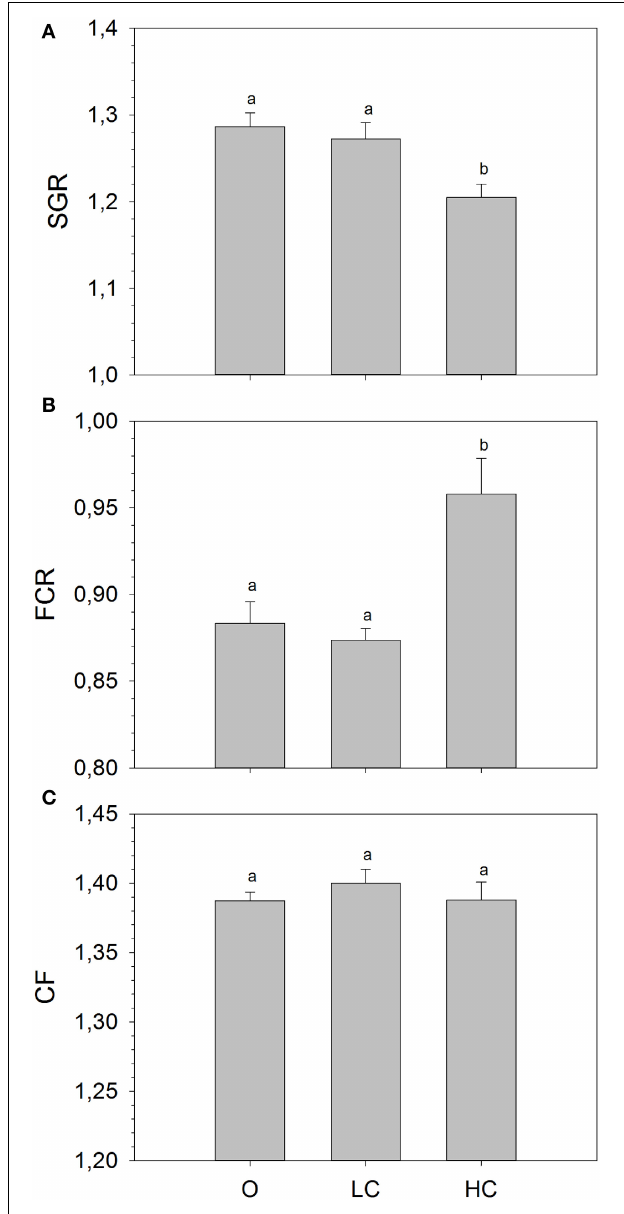
FIGURE 1 | (A) Specific growth rate (SGR), (B) Feed conversion ratio (FCR), and (C) Condition factor (CF) calculated for the entire duration of the growth trial. High current, HC = 1 BL s − 1 ; low current, LC = 0.5 BL s − 1 ; and O = no current (mean ± SE, n = 4). Different superscripts denote significant differences between